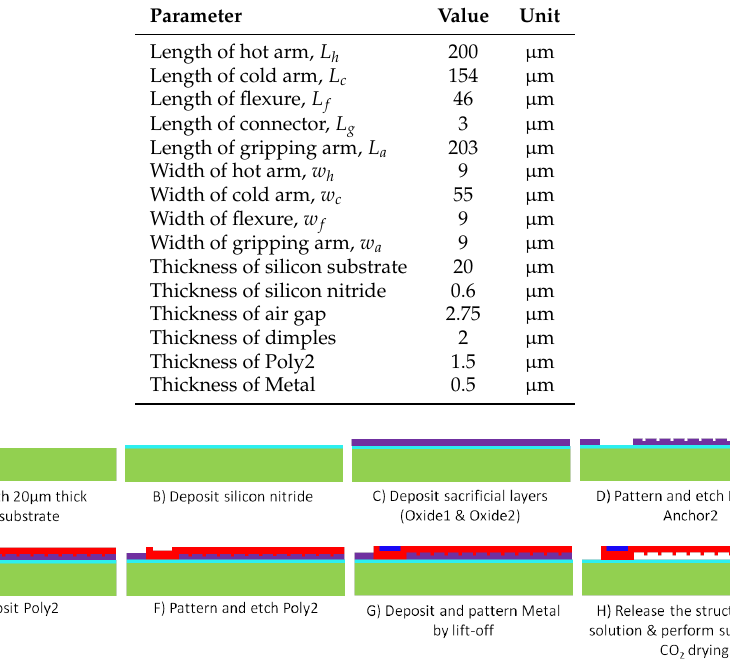
Table 1. Geometrical parameters of the fabricated microgripper.